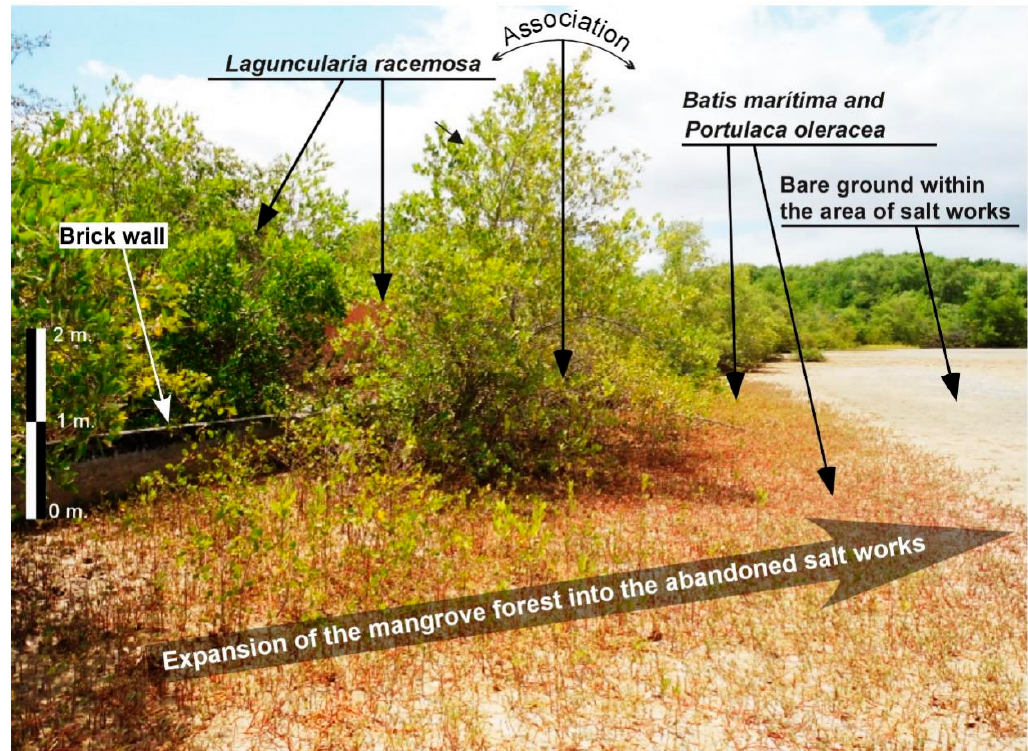
Figure 6. Features of the initial expansion zone of the mangrove vegetation in the abandoned salt evaporation ponds of the Margarida saltworks in the Ceará estuary, northeastern Brazil.